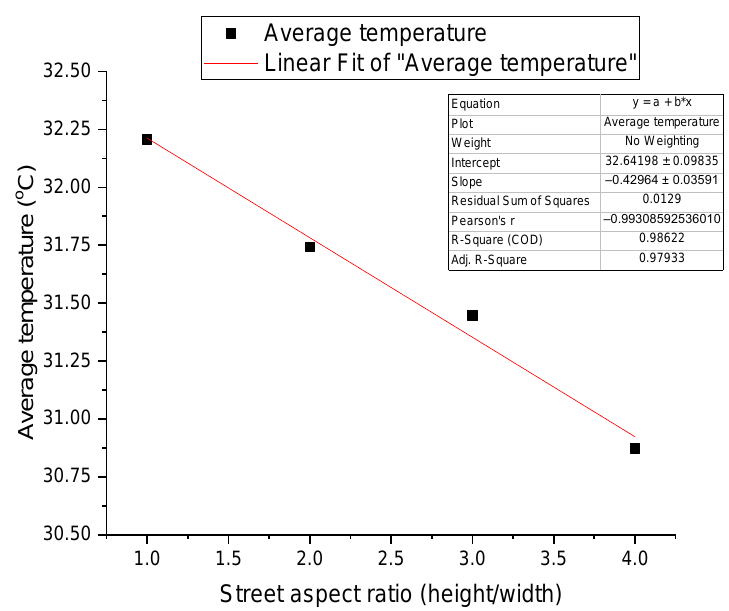
Figure 16. Variation of the inner surface temperature with aspect ratio.